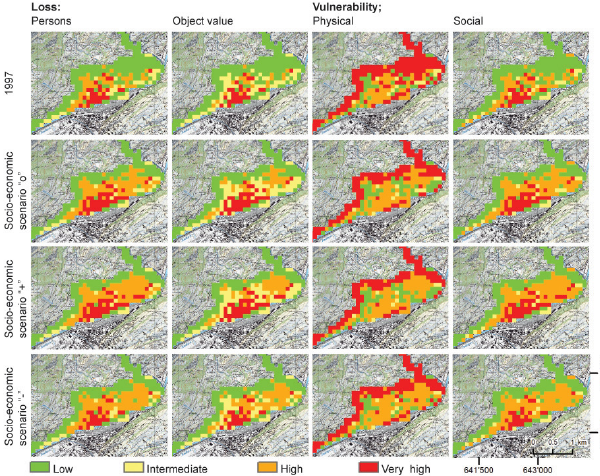
Figure 6. Spatial allocation of the assessment variables loss and vulnerability following the four-level scale defined in Table 2. DEM25 reproduced with permission of Swisstopo (BA110005) and BFS (1986, 1998).